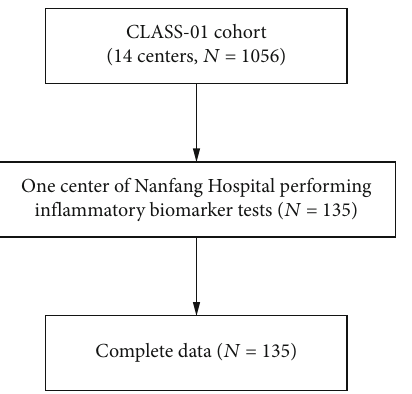
Figure 1: The fl owchart of population.